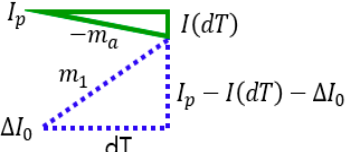
Figure 4. Comparison between ideal current and slope compensation.